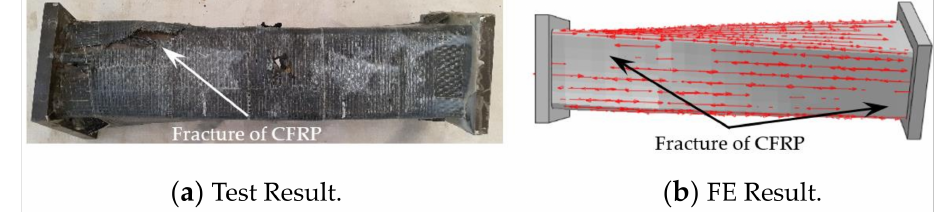
Figure 11. Failure mode of longitudinal CFRP.